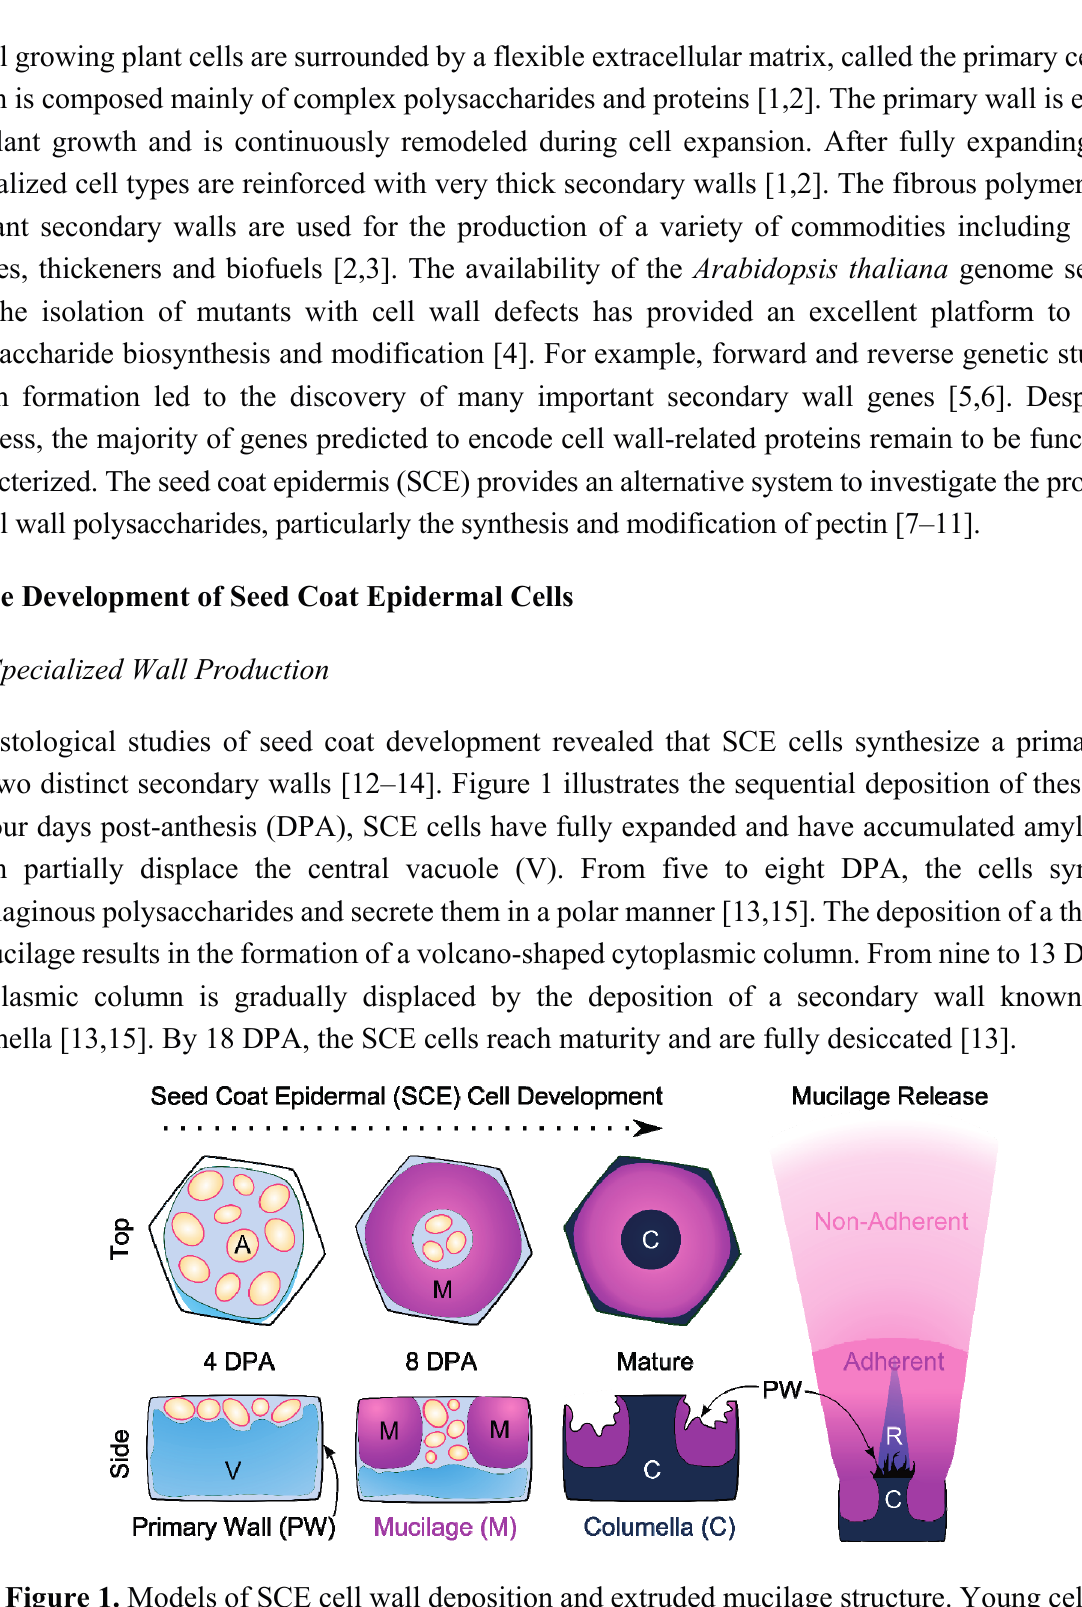
Figure 1. Models of SCE cell wall deposition and extruded mucilage structure. Young cells contain amyloplasts (A) and a large vacuole (V). Each SCE cell produces a mucilage ring, followed by a columella (C). Hydration of dry seed makes the mucilage burst out, rupturing the primary wall and forming a two-layered capsule and a ray-like structure